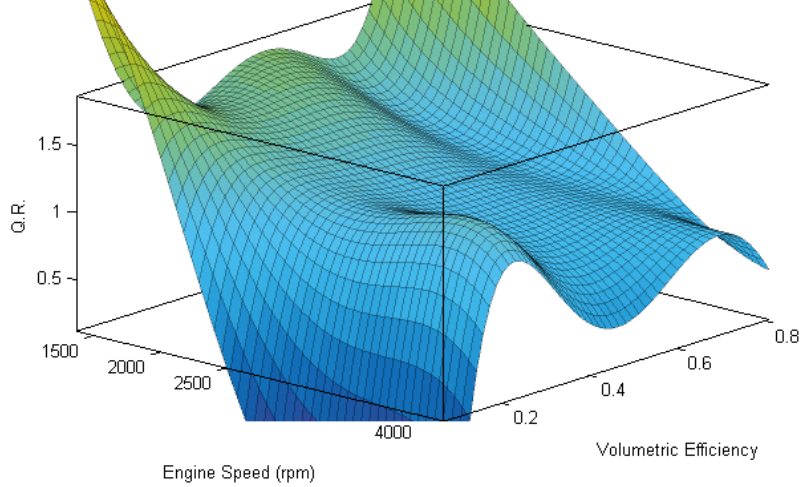
Figure 4. Map of calculated Heat Ratio Q.R. vs. engine speed and volumetric efficiency.